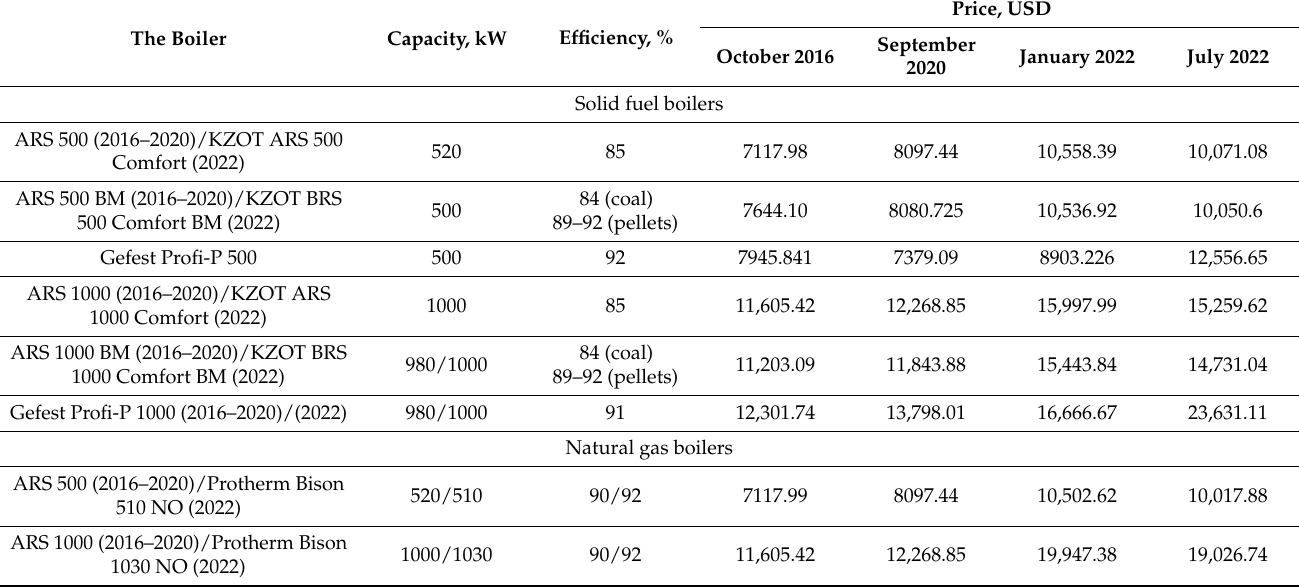
Table 3. Main characteristics of boilers and costs in 2016, 2020, and 2022